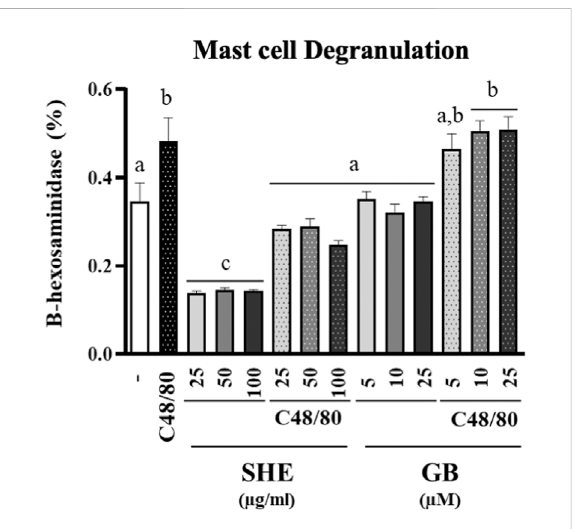
FIGURE 6 Determination of β -Hexosaminidase production in RBL-2H3 cells.Cellswereincubatedwith Serpylliherba extract(SHE)(25,50, and 100 μ g/ml) or gabapentin (GB) (5, 10, and 25 μ M) for 30 min and then stimulated with compound C48/80 or vehicle. Experiment was performed in triplicate. Data are expressed as means ± SEM. Groups with different letters are statistically different ( p <